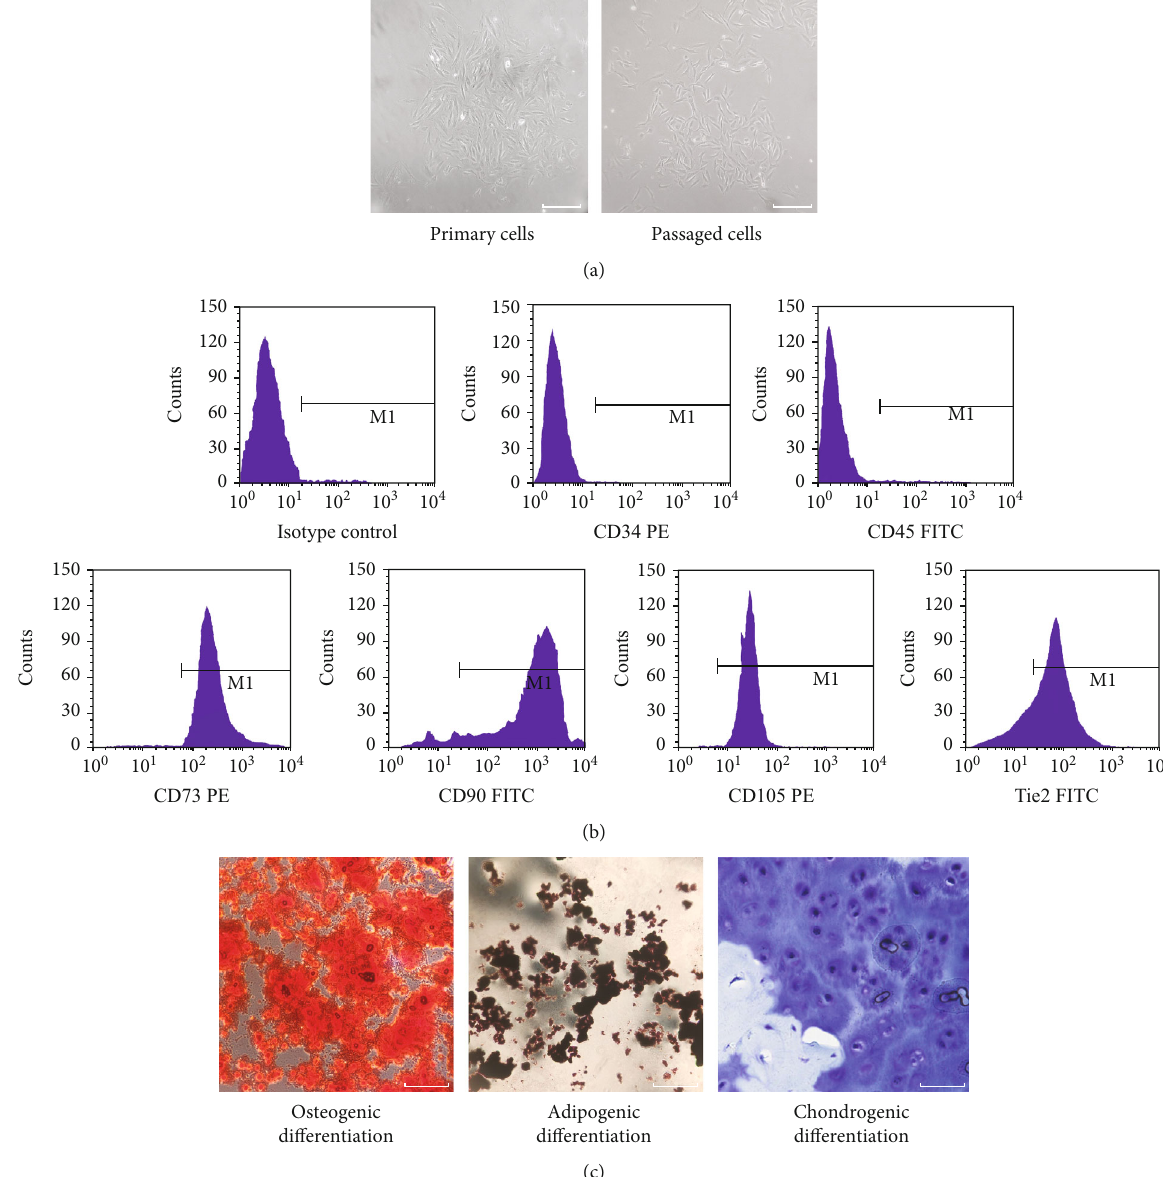
Figure 2: Identi fi cation of nucleus pulposus-derived mesenchymal stem cells (NPMSC). (a) Isolated primary cells presented with a long spindle shape and showed colony growth; the passaged cells were spindle-shaped. (b) NPMSC had higher expressions ( > 98%) of MSC surface markers CD73, CD90, and CD105 and lower expressions ( < 2%) of hematopoietic stem cell surface markers CD34 and CD45 and higher expressions ( > 80%) of Tie2. (c) NPMSC was positive for Alizarin red, Oil Red O, and Alcian blue staining after induced di ff erentiation. White scale bar = 50 μ m